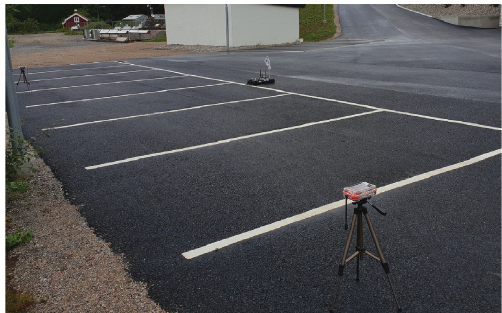
Figure 12: Our model car driving on a parking lot with two UWB anchors mounted on tripods in waterproof boxes.